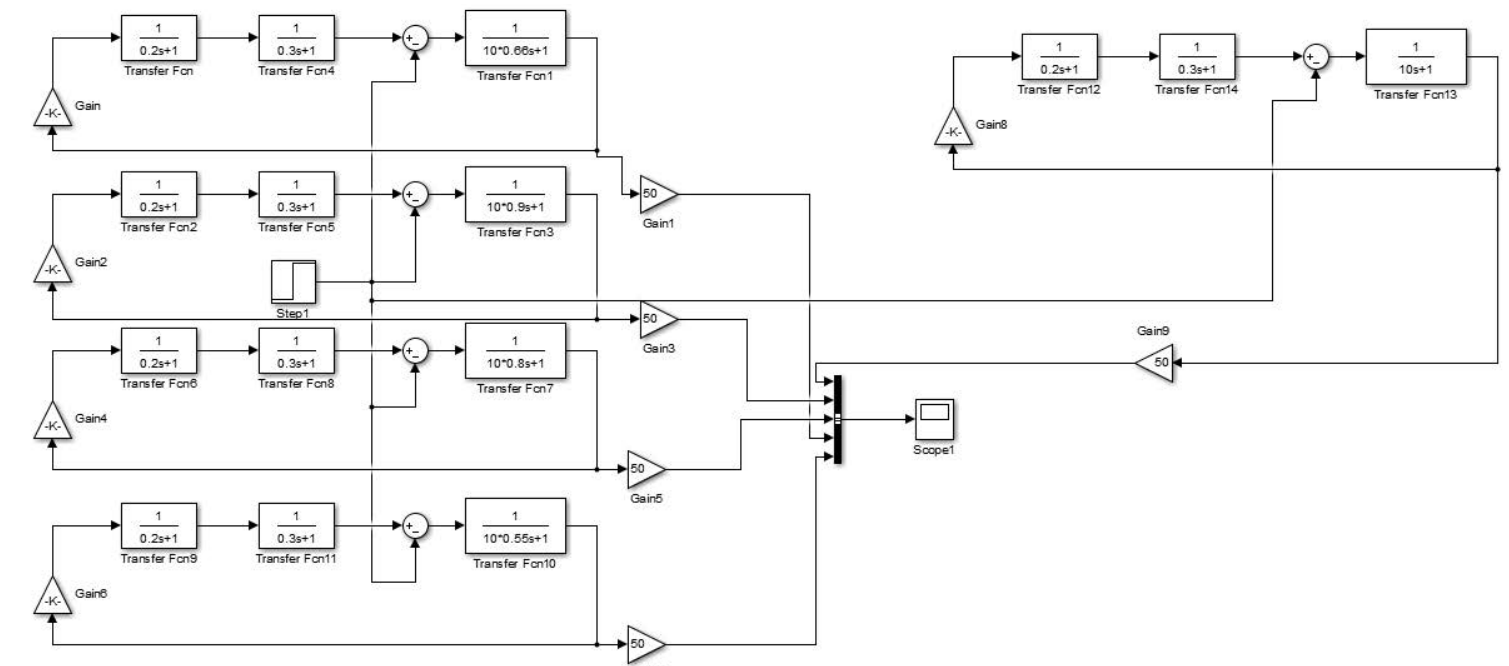
Figure 6. A block diagram of the primary control for frequency